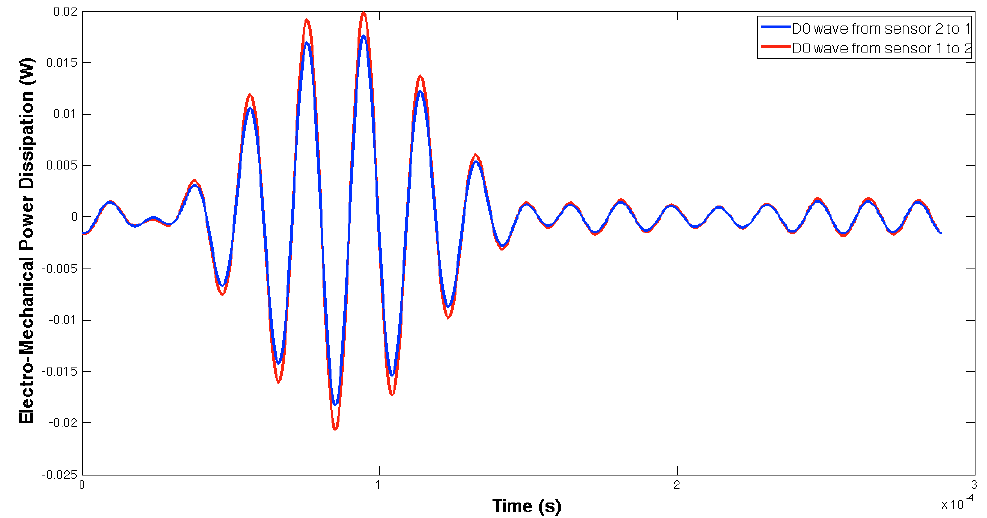
Figure 7. Differences in the EMPD in the aluminium lap-joint for damage D0 when the wave travels